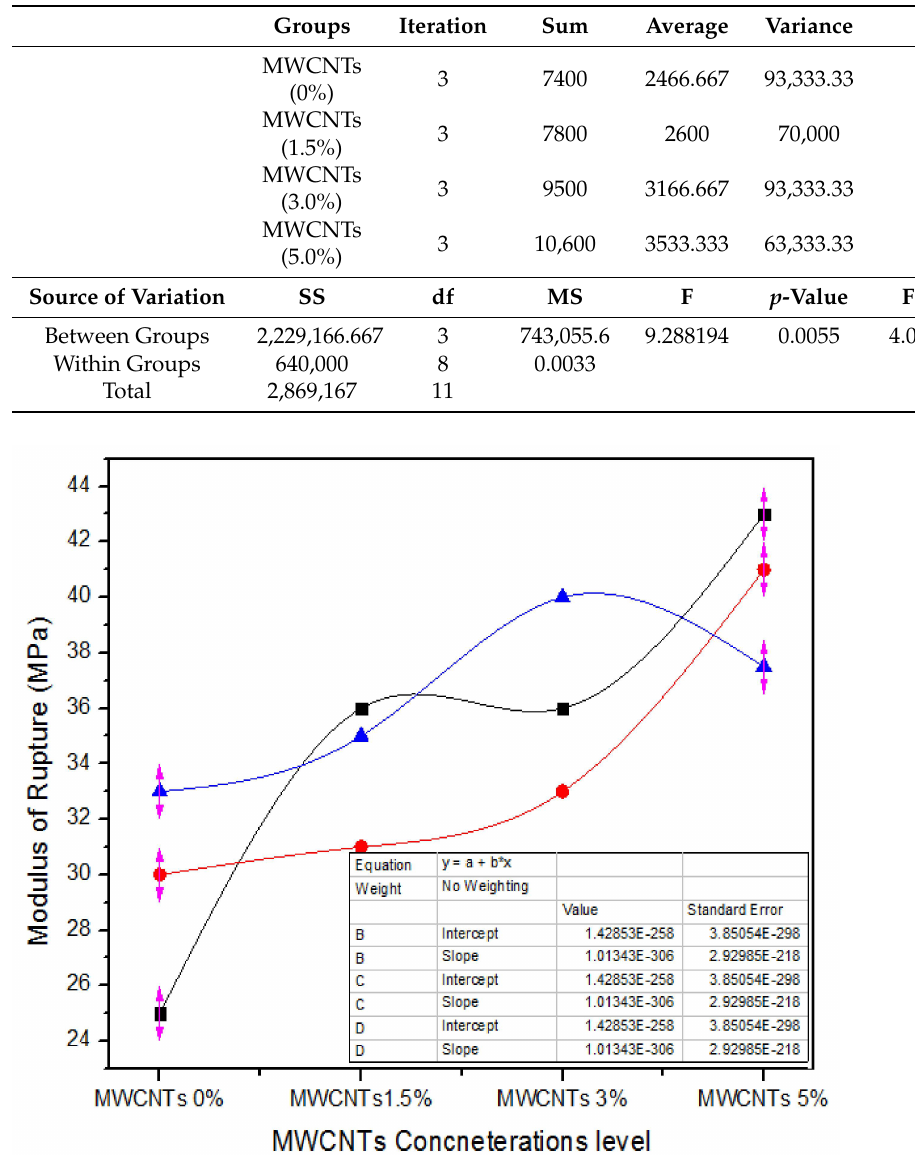
Table 10. MOE parameters of MWCNTs-UF nano-MDF for numerous counts.